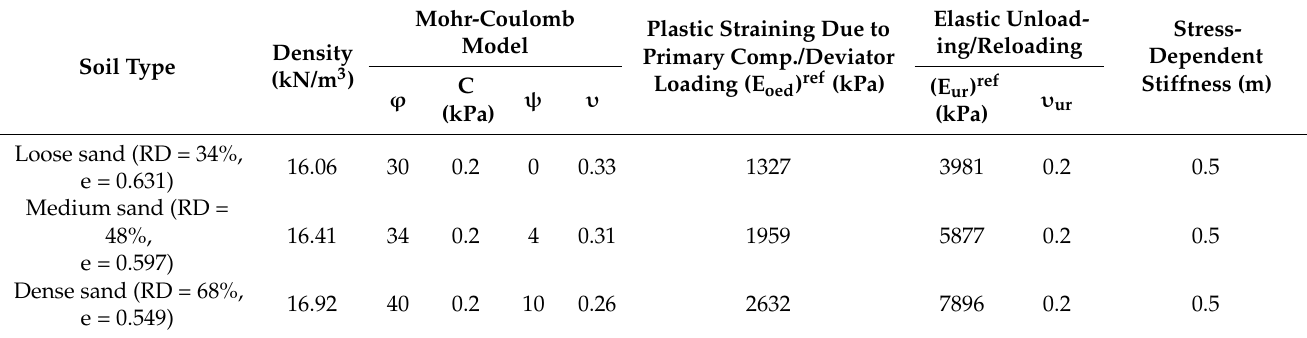
Table 4. Soil parameters of sand used in material model.